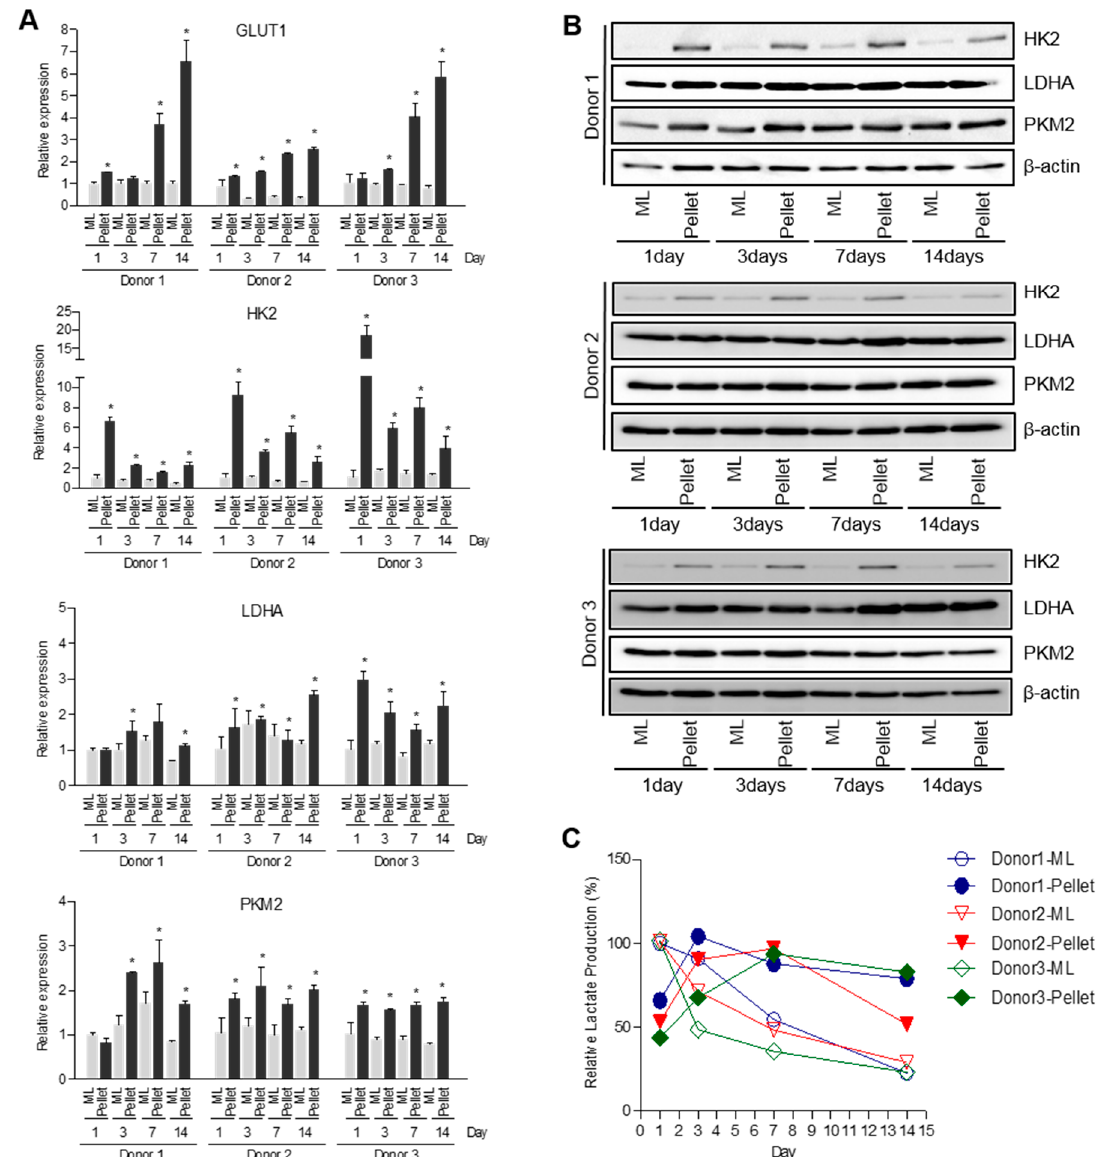
Figure 3. Alteration of energy metabolism in pellet culture system. Passage 5 human articular chondrocytes were cultured in monolayer or pellet culture system for 14 days. ( A ) GLUT1, HK2, LDHA and PKM2 mRNA expression levels were quantified by real-time qPCR. Data represent mean values ± SD from at least three independent experiments. * p < 0.05. n = 3. ( B ) HK2, LDHA and PKM2 protein expression levels were Western blot analysis. β -actin was used as a loading control. ( C ) Extracellular lactate levels secreted by cells in monolayer or pellet culture systems. Lactate concentration of monolayer culture for 1 day samples was assigned as 100%. ML, monolayer. Pellet, pellet culture system.